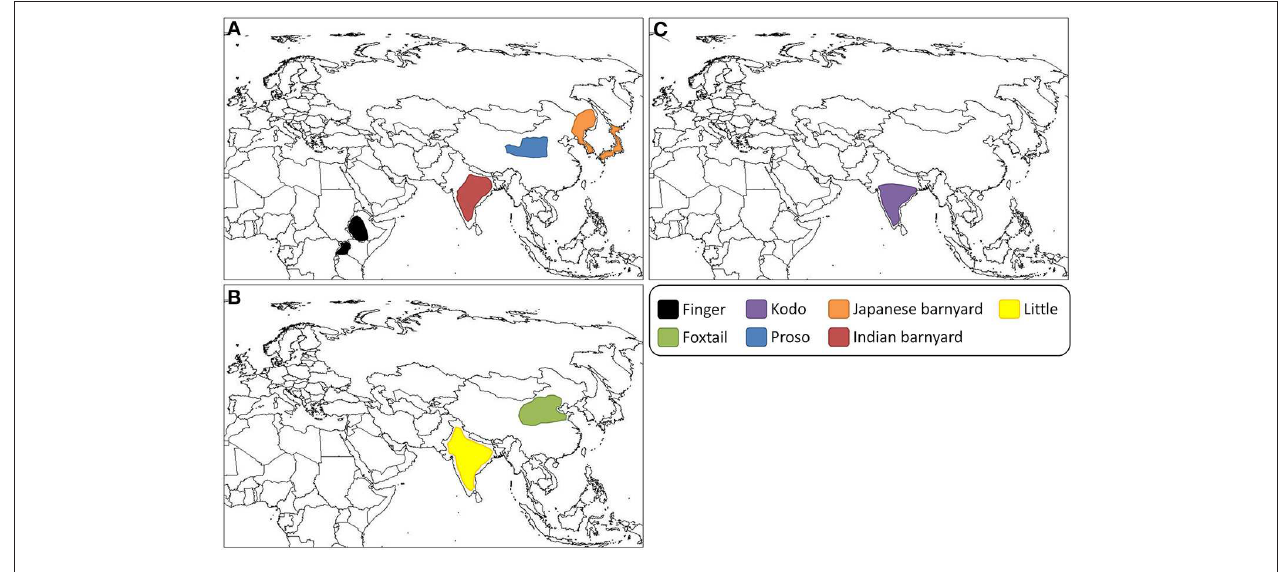
barnyard millet was domesticated at multiple sites across its current cultivation range in India (de Wet et al., 1983c). ( B ) Predicted sites of domestication of foxtail millet and little millet, respectively, on the North China Plain ( Yang et al., 2012) and in India (de Wet et al., 1983a). ( C ) Kodo millet may have been domesticated at multiple sites across its current range of cultivation in India (de Wet et al., 1983b).